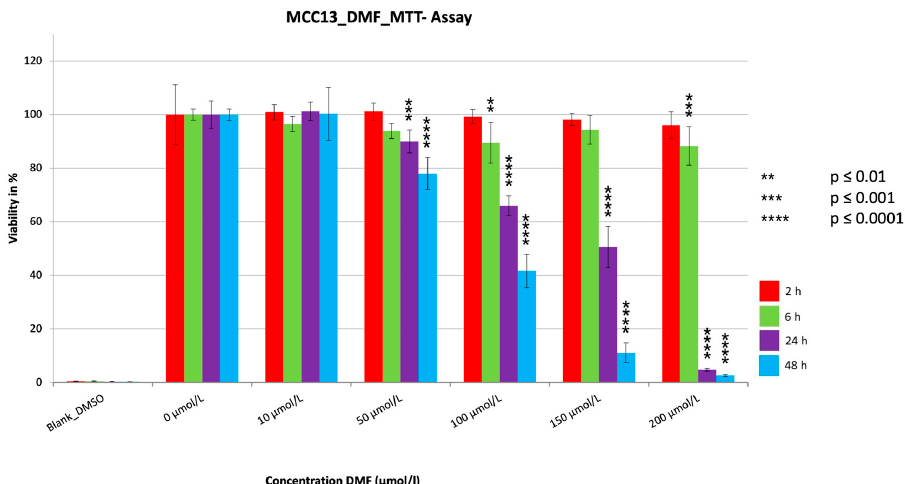
Figure 1. MTT measurement of the cell line MCC13 with a cell concentration of 30.000 cells/well with the addition of the substance DMF in different concentrations (10–200 µmol/L). Values are expressed as the mean ± SD of eight technical replicates. A multiple comparison test following the ANOVA was used to test whether there were significant differences between the individual mean values and the mean value of the normal control.